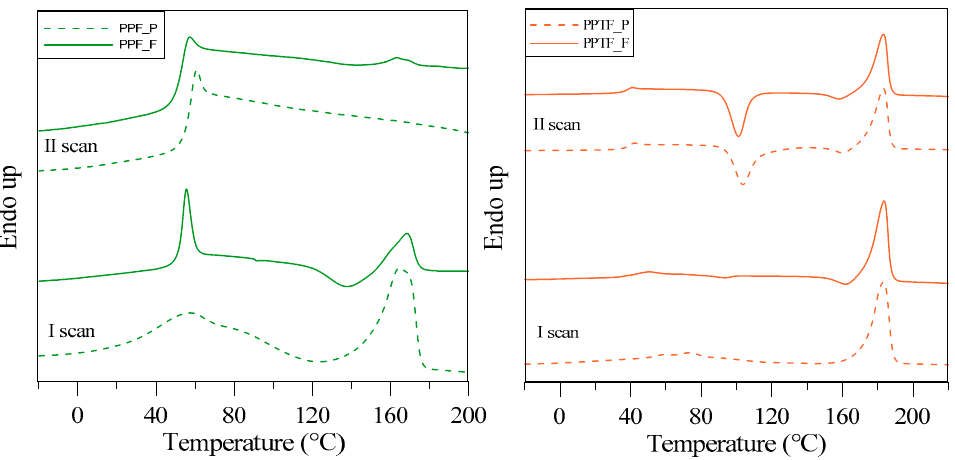
Figure 5. Calorimetric traces of PPF and PPTF powder and film (20 °C/min): 1st scan and 2nd scan after melt quenching.